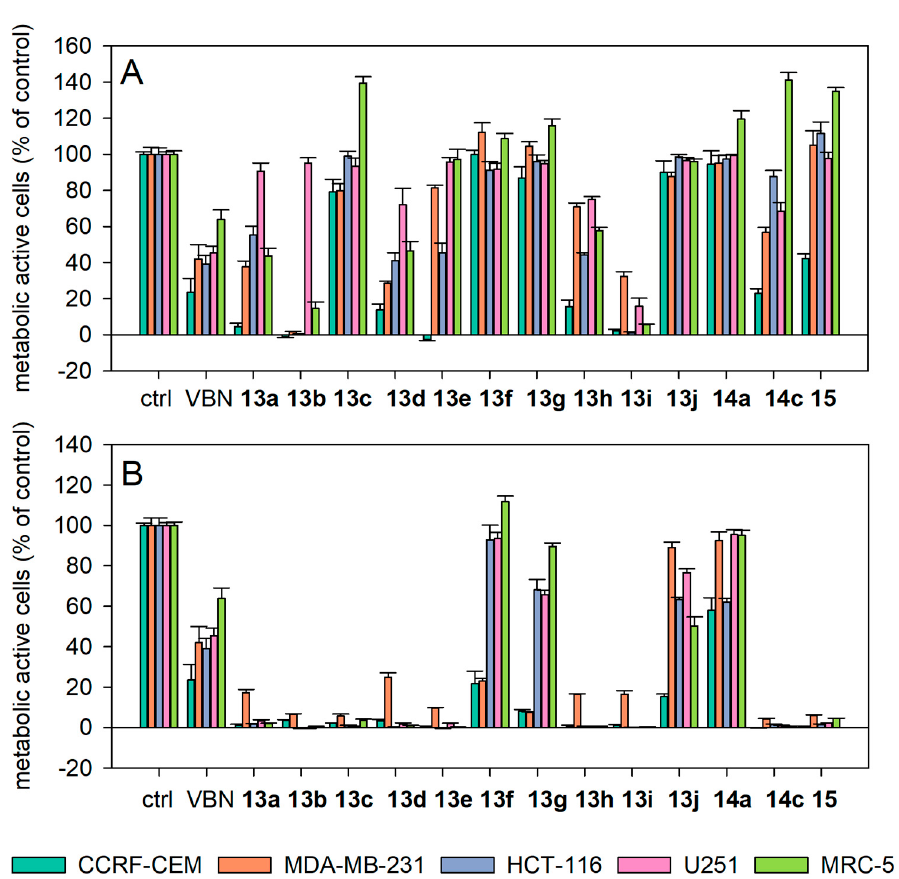
Figure 2. Results of the XTT a viability assay using leukemia (CCRF-CEM), breast cancer (MDA-MB-231), colon cancer (HCT-116), and glioblastoma cells (U251) as well as non-tumorigenic lung fibroblasts (MRC-5). Cells were treated with 5 µg/mL ( A ) or 50 µg/mL ( B ) of the derivatives for 72 h. Afterwards, the metabolic activities of the cells were measured. Vinblastine (VBN) served as the positive control (0.01 µg/mL). The results are expressed as a percentage of vehicle-treated (0.5% DMSO) control cells (ctrl) (mean ± s.e.m., n = 6). a (2,3-Bis-(2-methoxy-4-nitro-5-sulfophenyl)-2H-tetrazolium-5-carboxanilide).